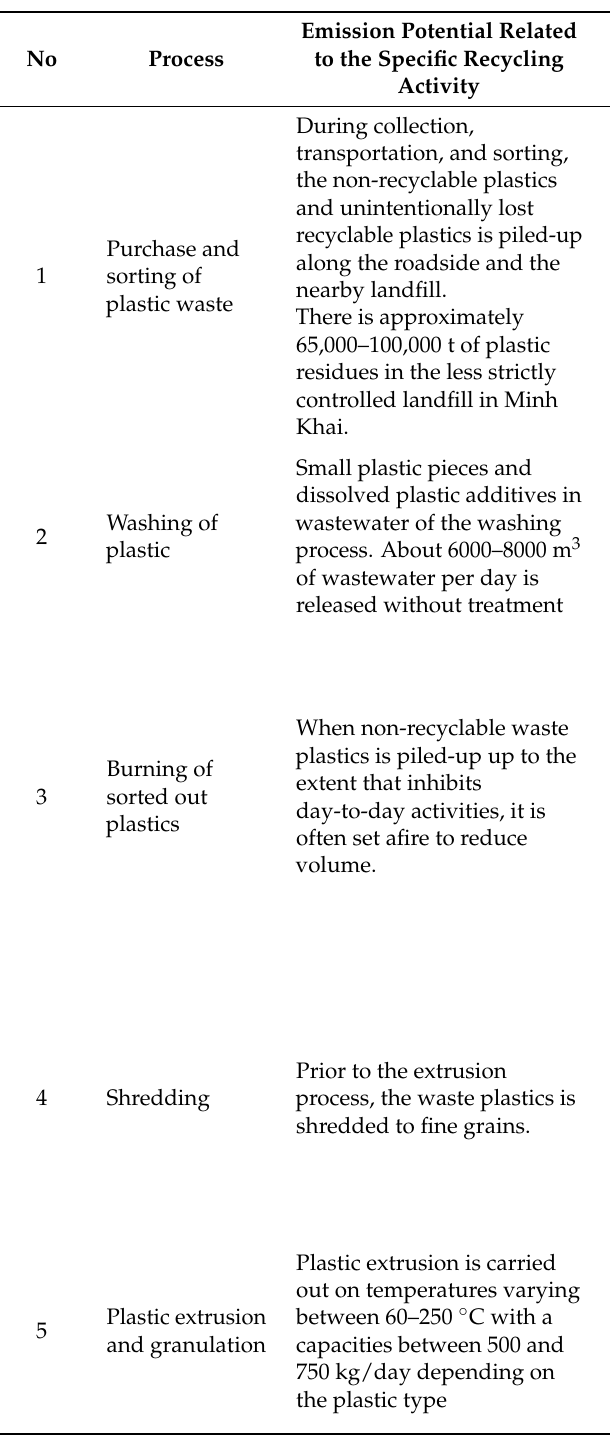
Table 1. Potential emissions resulting from specific informal waste plastic recycling at Phan Boi and Minh Khai craft villages activities with descriptions of their release pathways and corresponding scientific literature